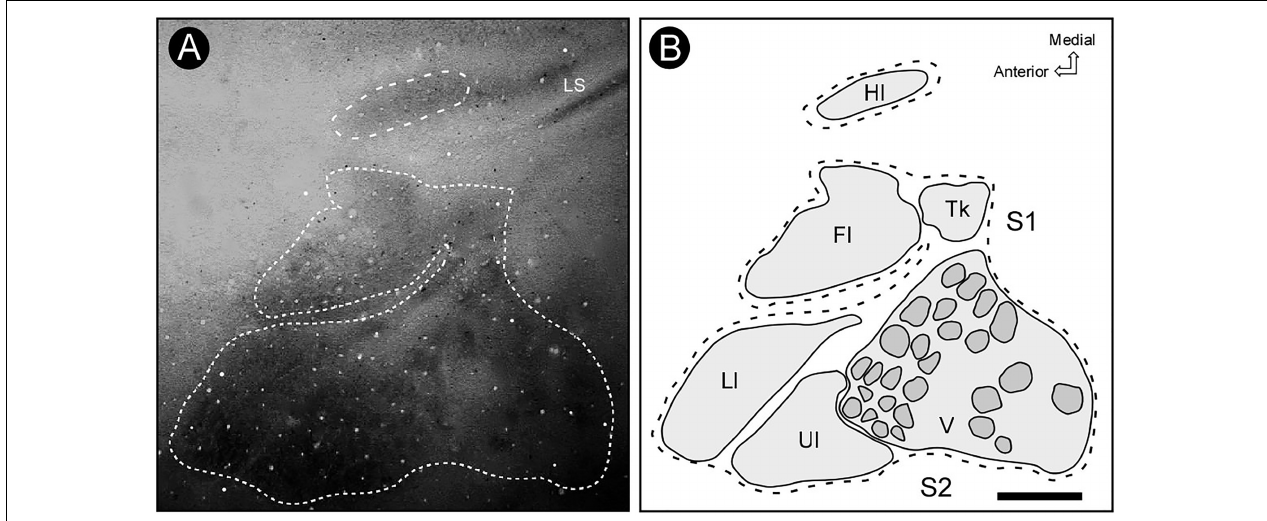
FIGURE 6 | Pattern of cytochrome oxidase (CO) reactivity across S1 area. (A) The CO pattern of distribution delimits precisely the distinct representations of the contralateral surface, which are congruent with the electrophysiologically defined borders – lips, limbs, trunk and also modules corresponding to individual vibrissae, in homology to the barrel field of small rodents (mouse and rat). (B) Reconstruction of histochemical limits of distinct regions in S1, including cortical modules in the representation of the face. Scale bar: 2 mm. Fl, forelimb; Hl, hindlimb; Ll, lower lip; Tk, trunk; Ul, upper lip; V, vibrissae; LS, lateral sulcus.